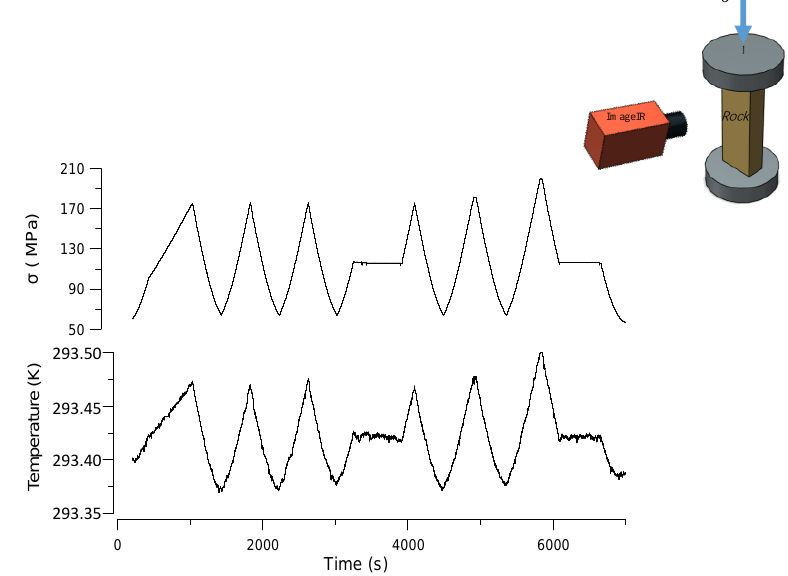
Figure 1. Variation in temperature during the uniaxial test on granite diorite.